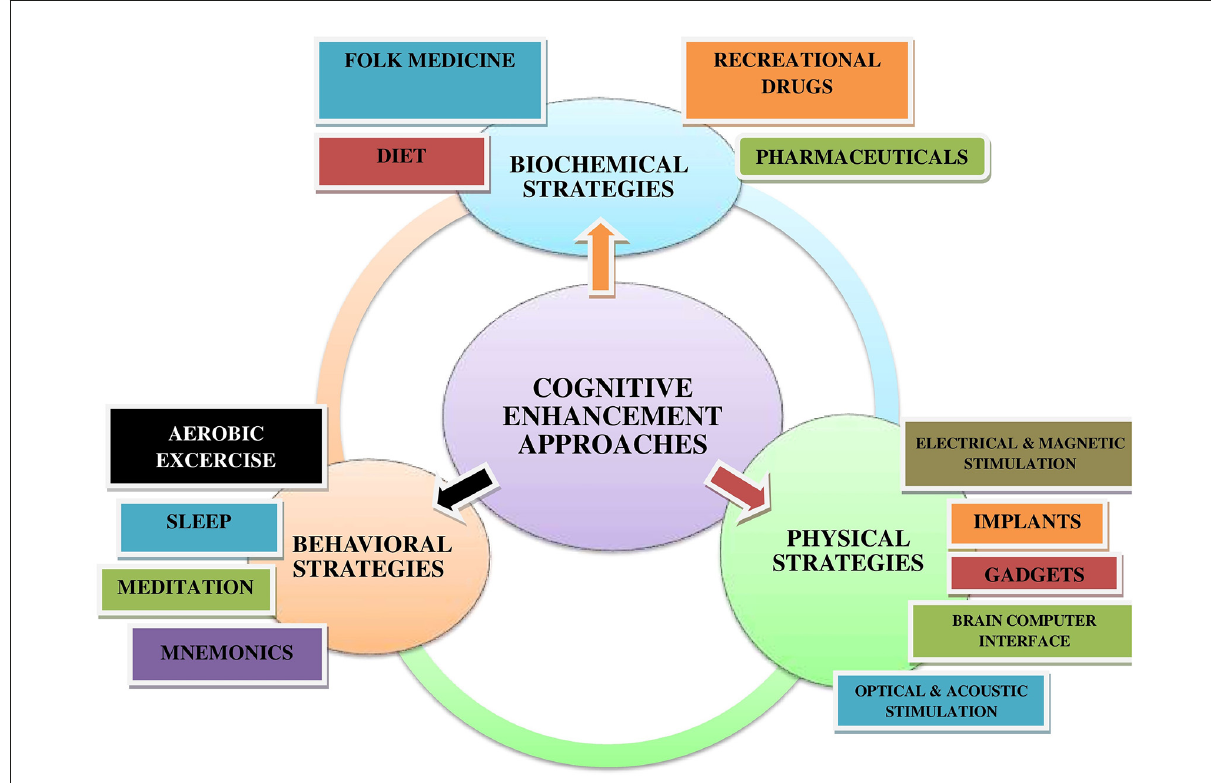
FIGURE2 Diagrammatic illustration of different cognitive enhancement approaches. As per the mode of action, biochemical, behavioral, and physical strategies are generally used to enhance cognition and brain augmentation.